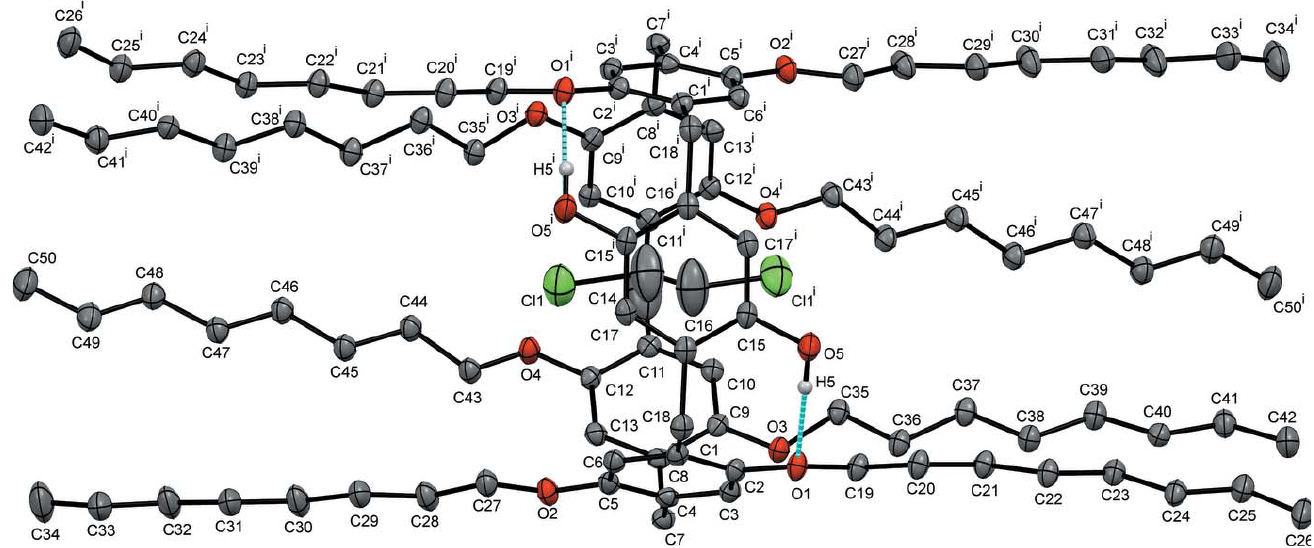
Figure 1 Displacement ellipsoid representation (30% probability) of Pil-OctOH (cid:2) C 2 H 4 Cl 2 . Hydrogen atoms are omitted for clarity except for those of the hydroxy groups. Blue dotted lines indicate intramolecular hydrogen bonds between the hydroxy groups and the oxygen atoms of adjacent octyloxy moieties. [Symmetry code: (i) (cid:3) x + 1, y , (cid:3) z + 1 .] 2